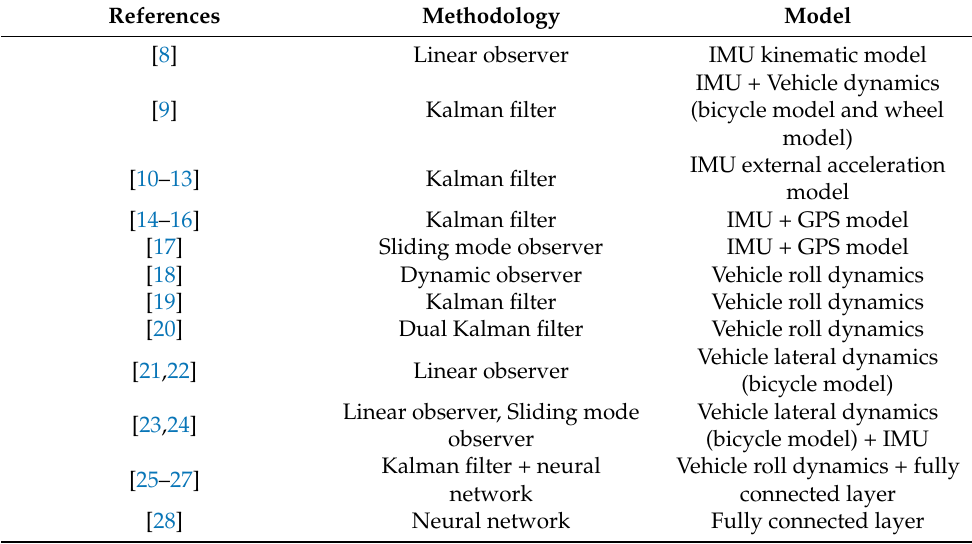
Table 1. Literature review